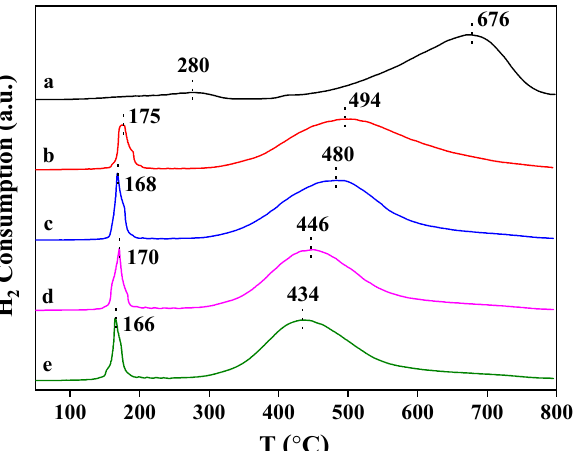
Figure 6. H 2 -TPR profiles of Pt n /Ni 1.5 Co 0.5 AlO catalysts: (a) Ni 1.5 Co0.5AlO; (b) Pt 1 /Ni 1.5 Co 0.5 AlO; (c) Pt 2 /Ni 1.5 Co 0.5 AlO; (d) Pt 4 /Ni 1.5 Co 0.5 AlO; (e) Pt 6 /Ni 1.5 Co 0.5 AlO.